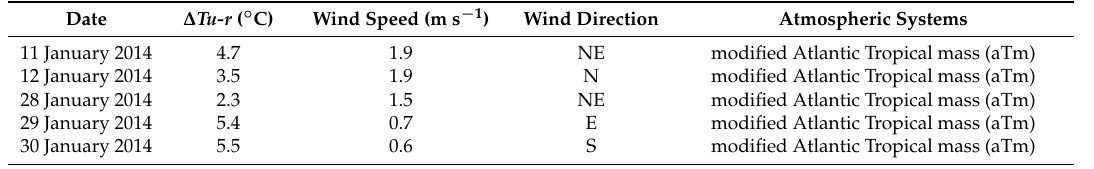
Table 1. Urban heat island magnitude and atmospheric systems during nighttime traverses in Paranava í , January 2014.